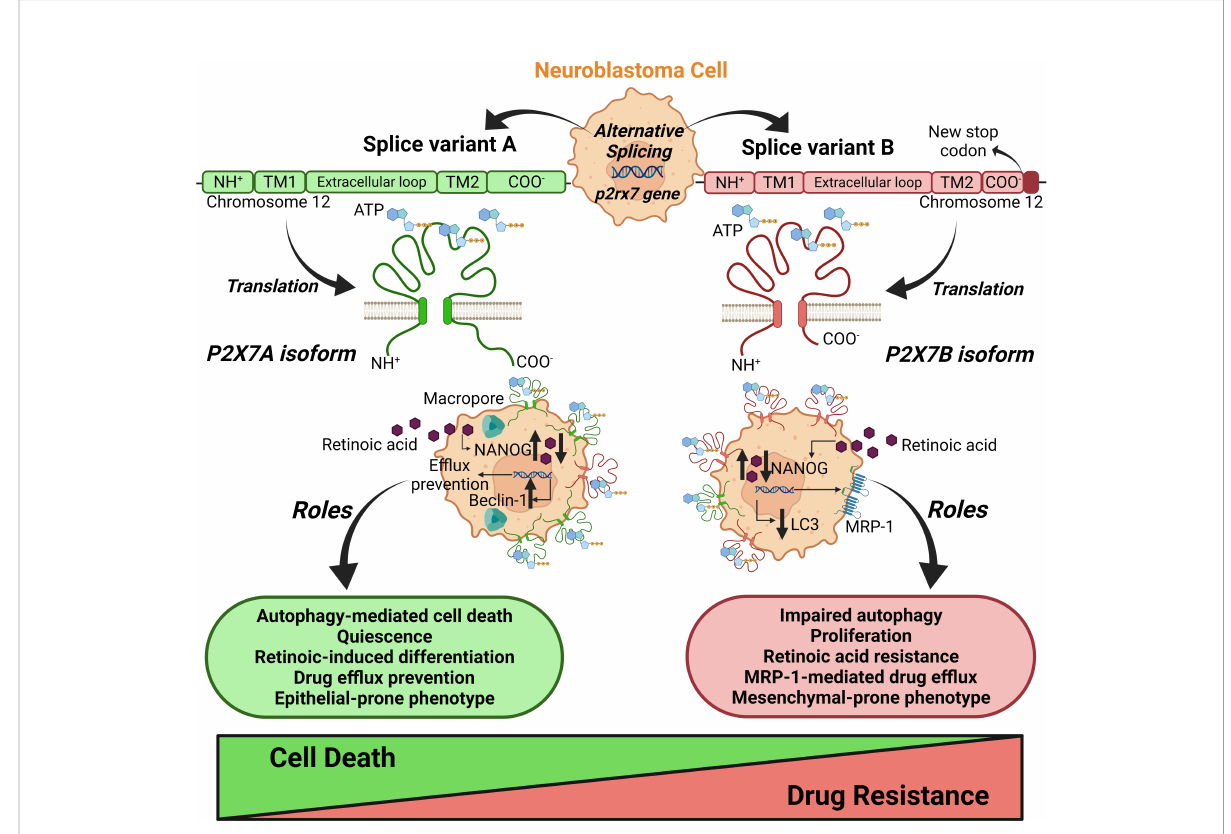
FIGURE 10 Schematic representation of the roles of splice variants of the p2rx7 gene in neuroblastoma chemoresistance. The alternative splicing of the p2rx7 gene localized on chromosome 12 generates several mRNA variants that are translated into nonfunctional or only two well-characterized functional ion channels, the A and B isoforms. P2X7A corresponds to the full-length variant, and P2X7B is produced by the retention of an intron containing a stop codon, which shortens the protein length. This truncated version lacks the C-terminal tail that has been described as crucial to macropore opening observed in cells expressing P2X7A. These structural differences in splice variants determine distinct contributions of the P2X7 receptor to neuroblastoma drug resistance. The P2X7A receptor is crucial for macropore-dependent autophagy-mediated cell death and quiescence induction and downregulates ef fl ux pumps. P2X7A favors retinoid sensitivity for neuroblastoma cell differentiation and epithelial phenotype. The B isoform plays a primary role in cell proliferation (16) to favor drug resistance. The P2X7B receptor is important for resistance to retinoids, retaining cells in a stem-like phenotype, and ef fl ux of drugs via MRP-type transporters. B isoform-expressing cells show impaired autophagy and a mesenchymal-prone phenotype. Taken together, these fi ndings reveal counterbalancing roles for the A and B isoforms in neuroblastoma cells. Created with